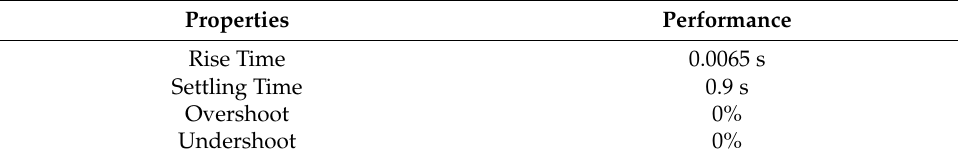
Table 3. Controller performance.